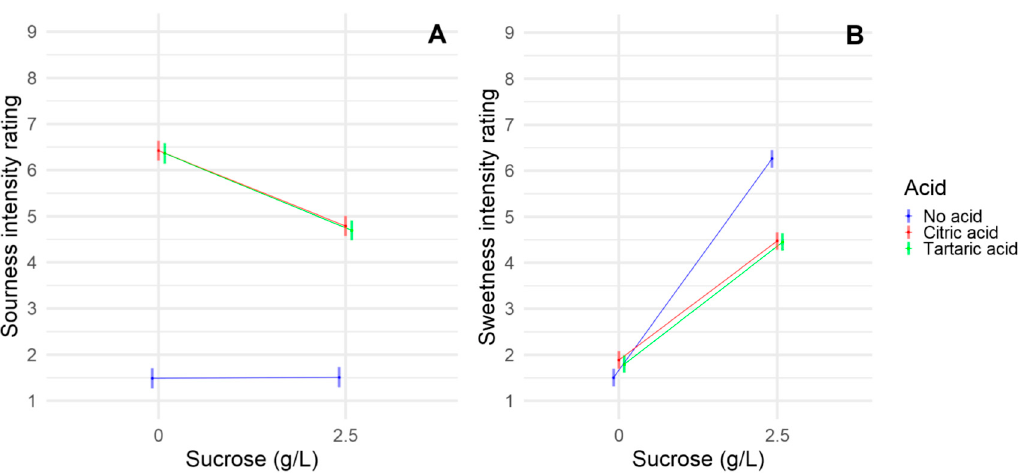
Figure 1. Interaction plots showing the means for the interaction between acids and sucrose. ( A ) Sourness intensity ratings; ( B ) sweetness intensity ratings. Means are full dots. Surrounding faded lines indicate 95% confidence intervals.